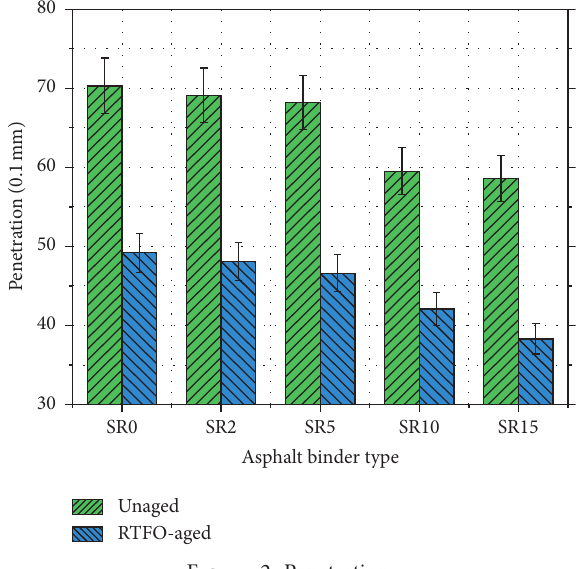
Figure 1: The gradation of AC-16 in this